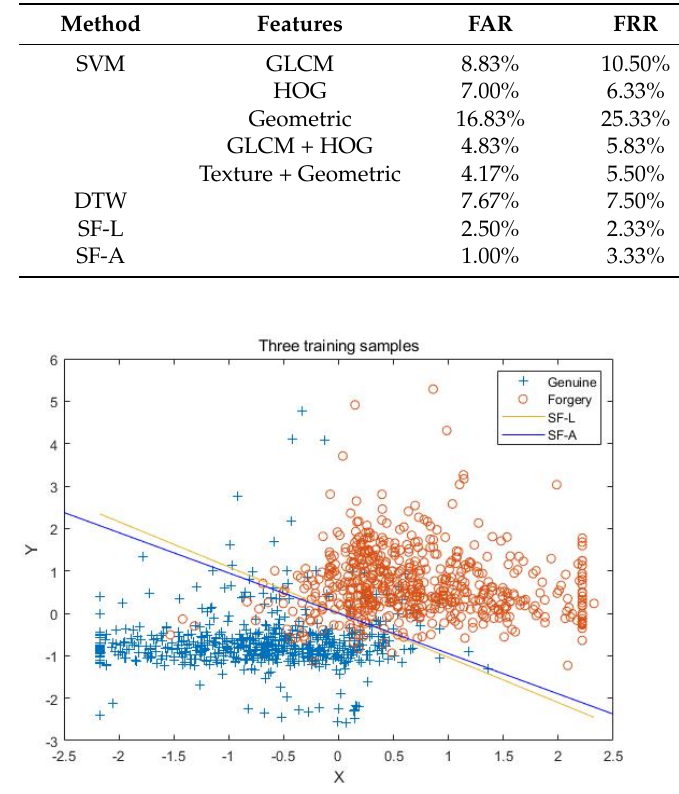
Figure 3. Sample distribution when using three training samples.